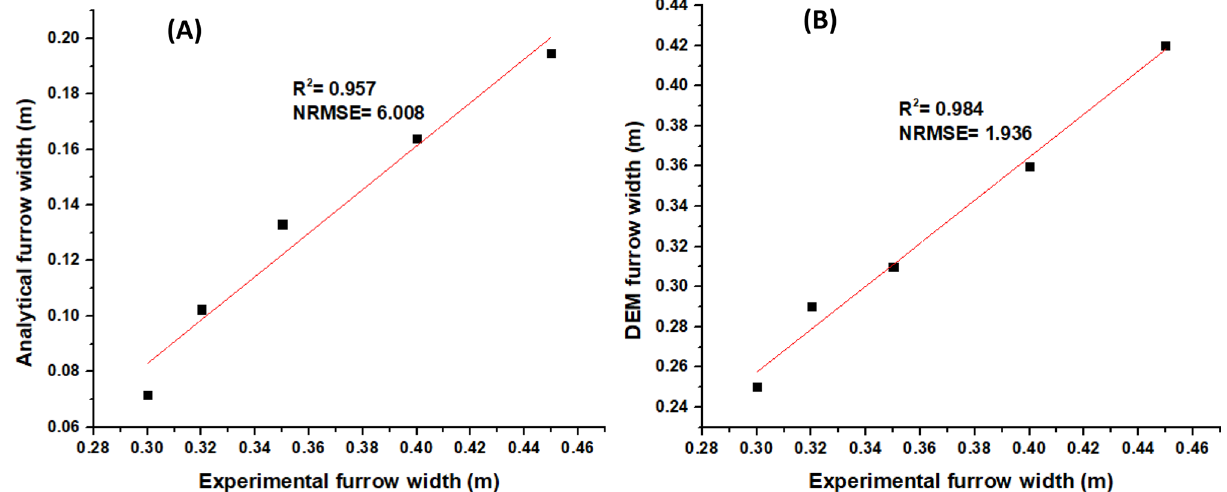
Figure 10. Comparison between predicted ( A ) Analytical model ( B ) DEM model and measured width of furrow for a subsoiler.